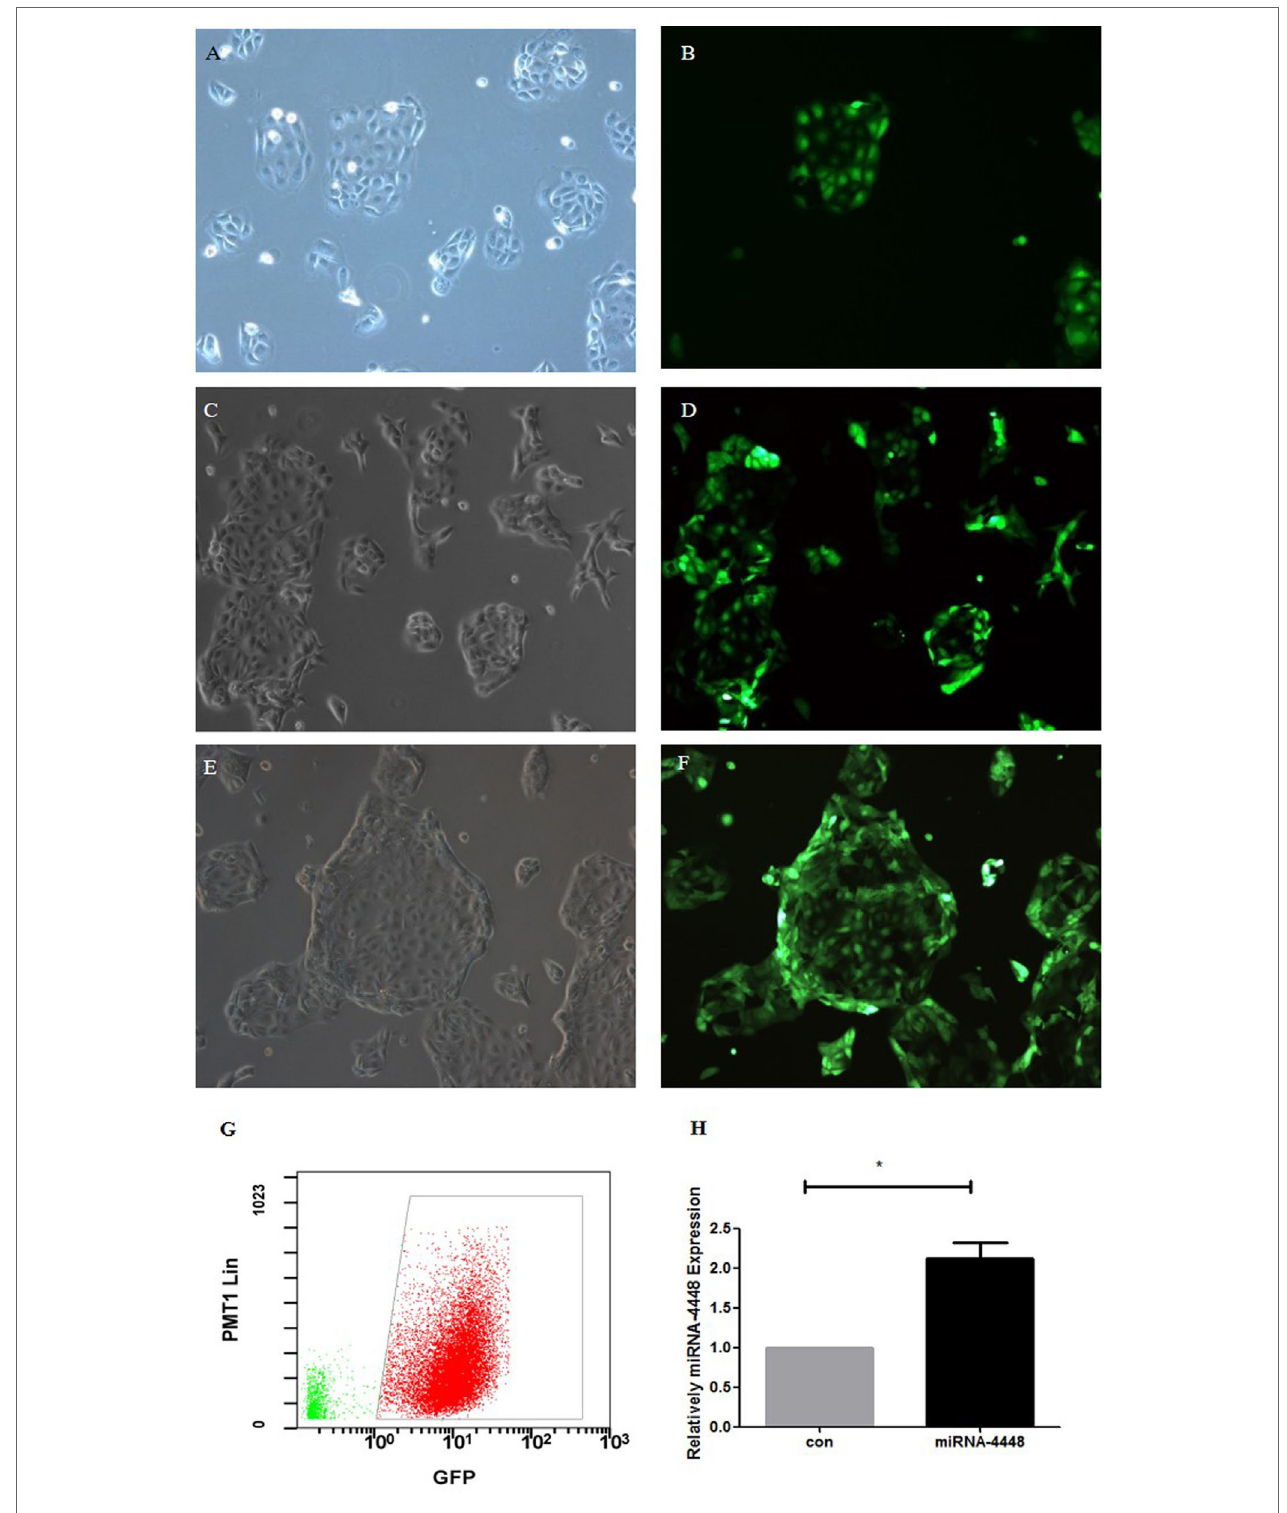
FigUre 3 | Overexpression of miRNA4448 in pLenti-CMV-GFP-miR-4448 human corneal epithelial cells (HCECs). The cell morphology and GFP fluorescence was examined after pLenti-CMV-GFP-miR-4448 was transfected for 24 h (a,B) , 48 h (c,D) , and 72 h (e,F) and imaged using phase contrast microscopy (left column) and fluorescent microscopy (left column). (g) Flow cytometry was used to sort the GFP ( + ) cells to establish the pLenti-CMV-GFP-miR-4448 and the pLenti-CMV- GFP-NC HCEC lines, which contained GFP ( + ) cells at concentrations up to 96.3%. (h) RT-PCR demonstrated the expression levels of miRNA4448 were upregulated in the pLenti-CMV-GFP-miR-4448 HCEC line. * p < 0.05 vs. pLenti-CMV-GFP-NC. GFP, green fluorescent protein.